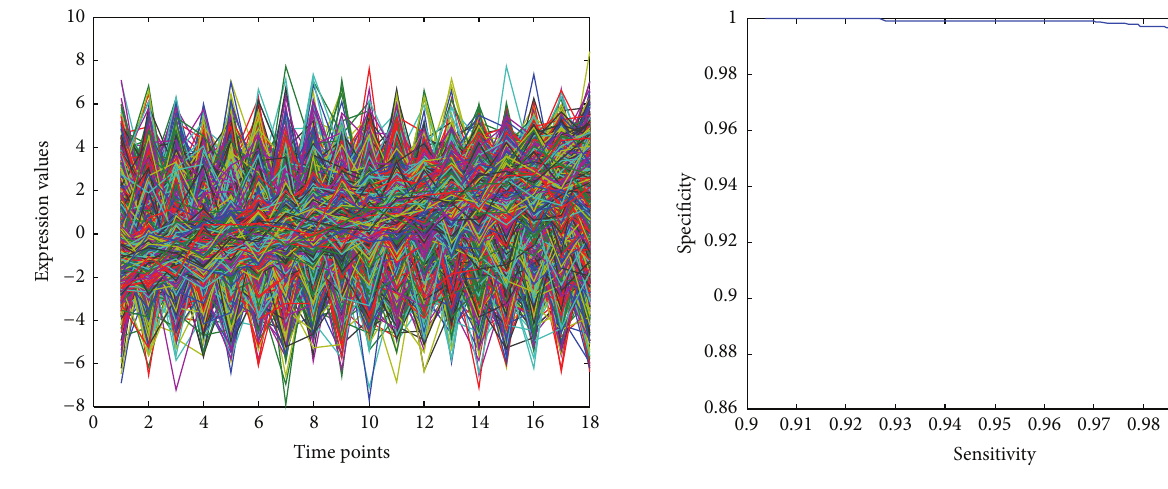
Figure 2: Plot of sensitivity versus